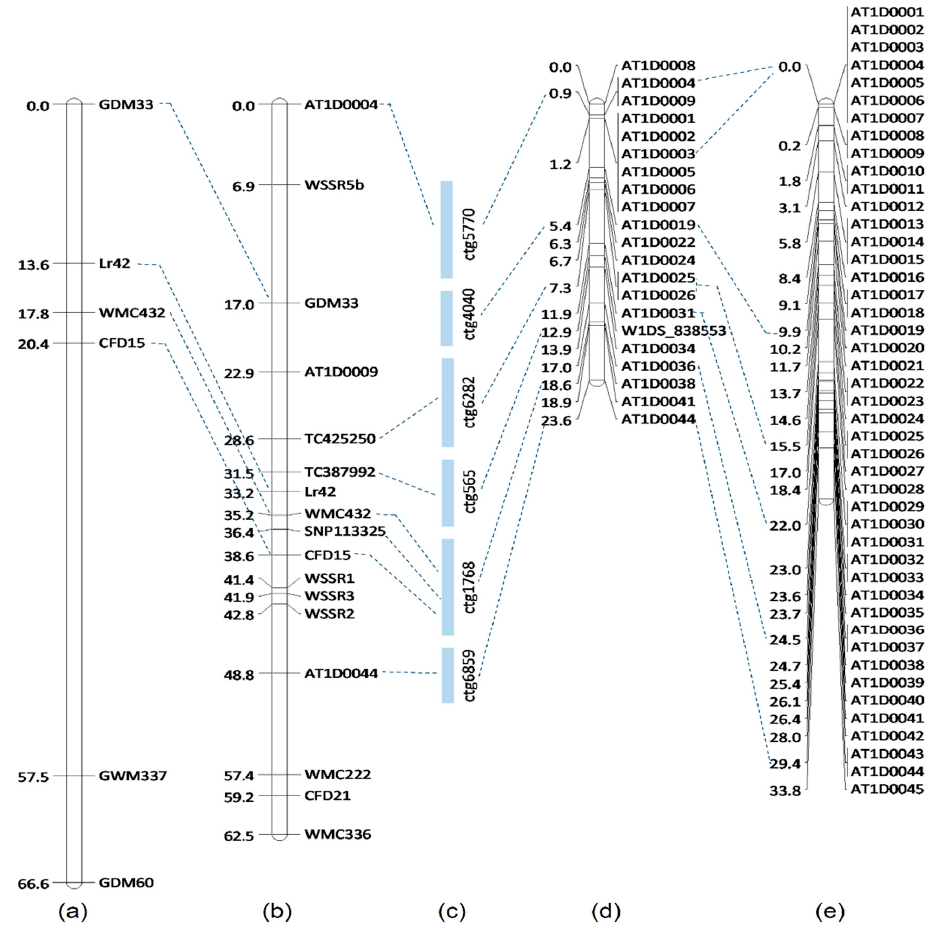
Figure 1. Comparative genetic and physical map of the leaf rust resistance gene Lr42 : ( a ) genetic map in a KS93U50 / Morocco F 2 population [21]; ( b ) genetic map in a KS93U50 / Morocco F 5 recombinant inbred line (RIL) population (current study); ( c ) physical mapping of the Lr42 region on Chinese Spring 1D bacterial artificial chromosome (BAC) contigs (current study), and ( d ) Prelude (TA2988) / synthetic wheat (TA8051) RIL population (current study), and ( e ) an Ae. tauschii AL8 / 78 (TA10132) / AS75 F 2 population [19].